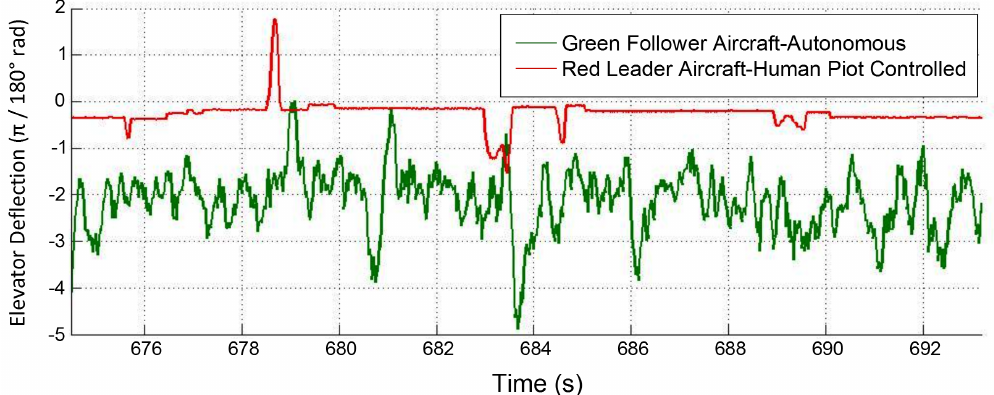
Figure 11. Comparison of red and green “Phastball” elevator commands in formation flight for Steady Level Flight Phase (SLFP).